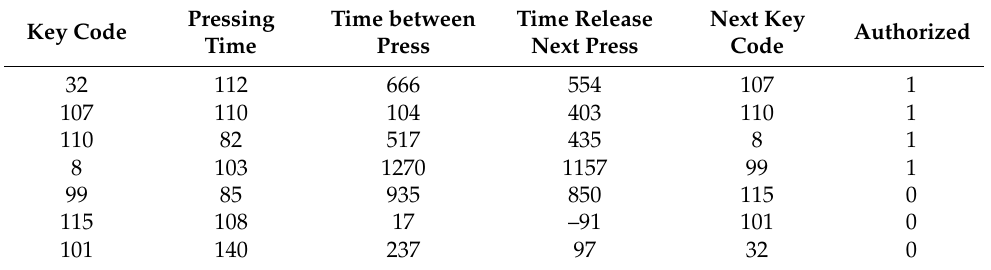
Table 2. Structure of the transformed dataset: headers and a sample of data